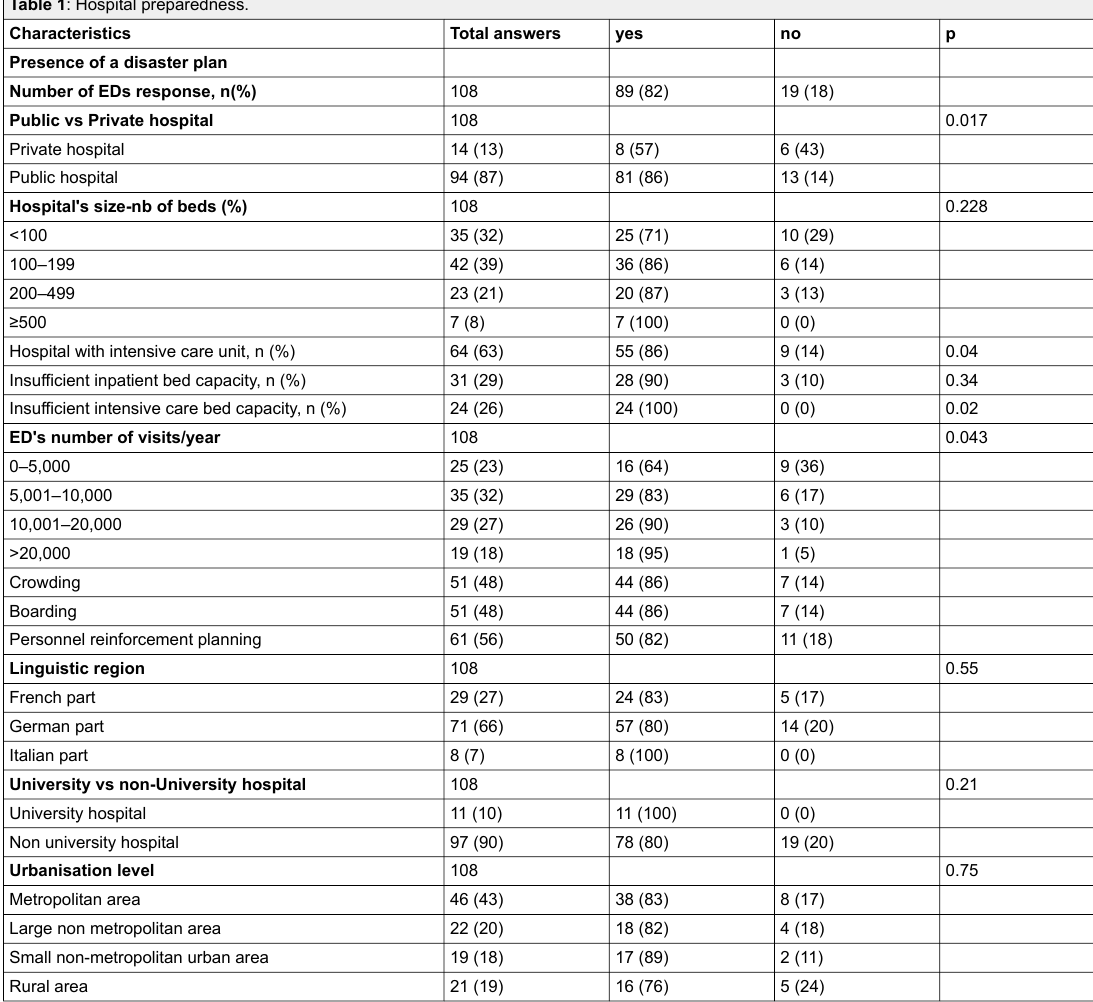
Table 1 : Hospital preparedness.